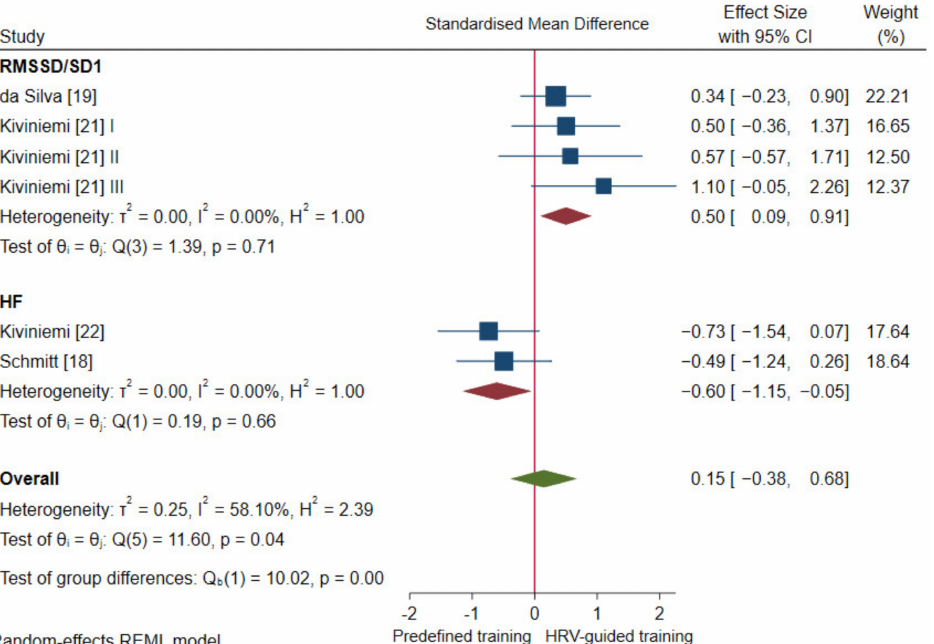
Figure 3. Test for subgroup comparisons for standing vagal-related HRV indices based on the HRV index used. I, II, III refer analysis units from the same study.